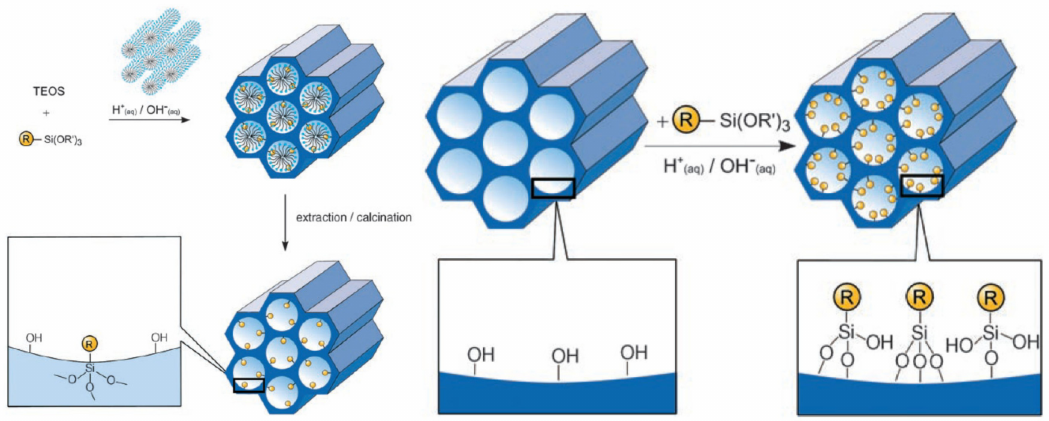
Figure 5. A schematic presentation of the organic functionalization methods for mesoporous silica materials. ( A ) Co- condensation method and ( B ) grafting method. Reproduced with permission from [52], WILEY-VCH Verlag GmbH and Co. KGaA,